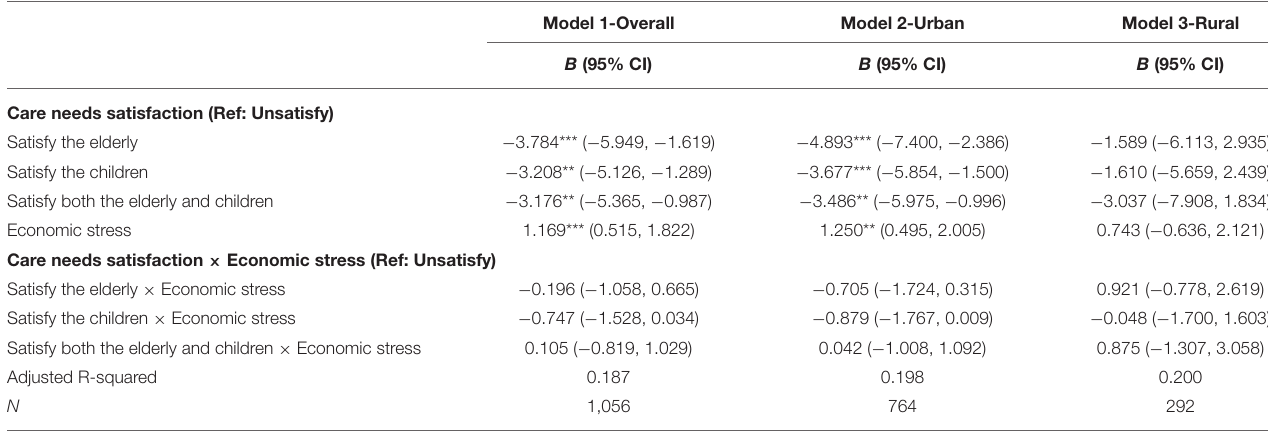
TABLE 5 | Multiple liner regression analysis of the interaction effect of family care needs satisfaction and economic stress on depressive